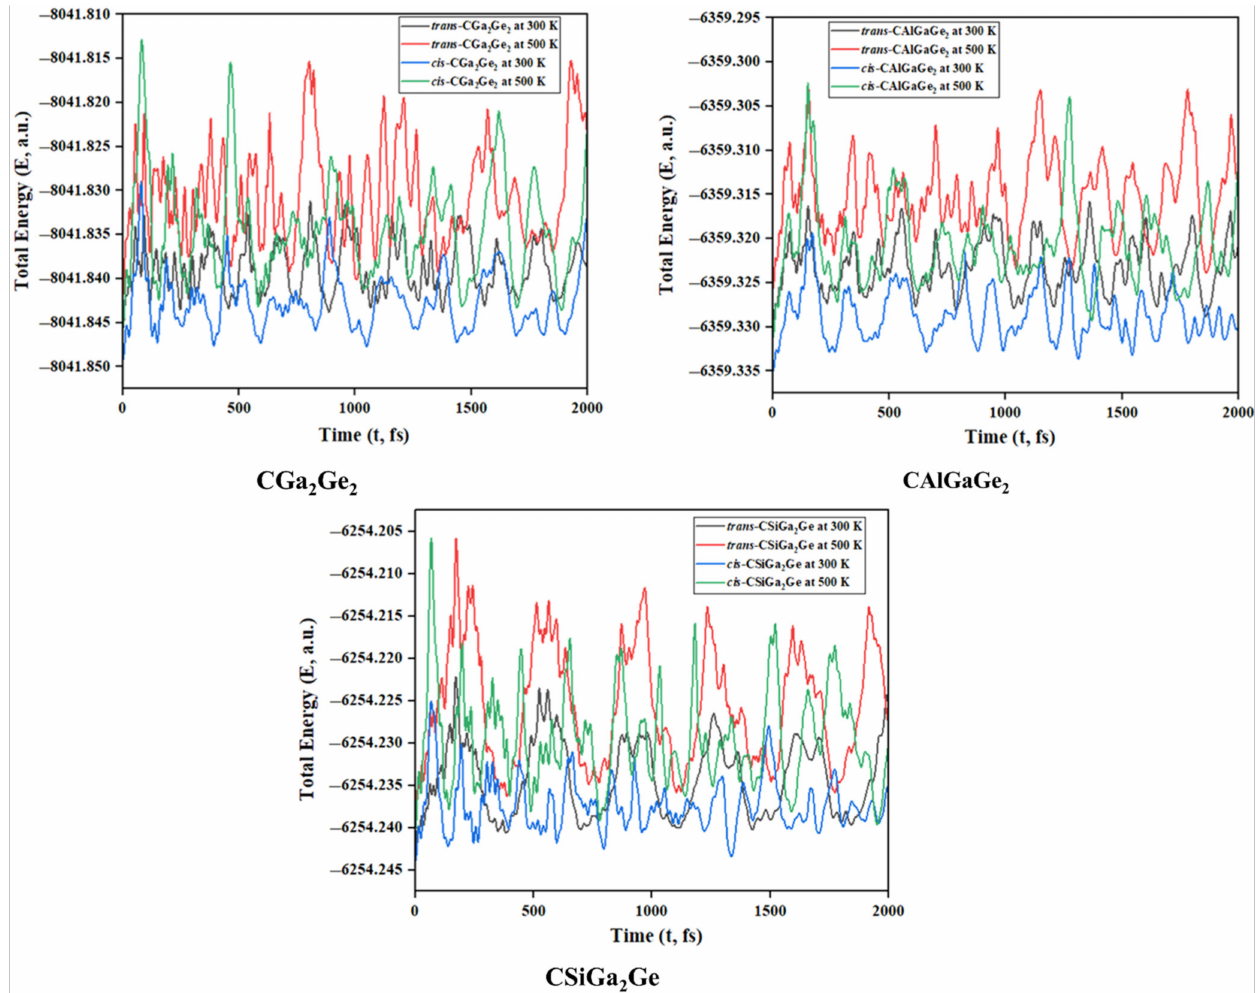
Figure 2. Time evolution of total energy for CGa 2 Ge 2 , CAlGaGe 2 , and CSiGa 2 Ge systems,